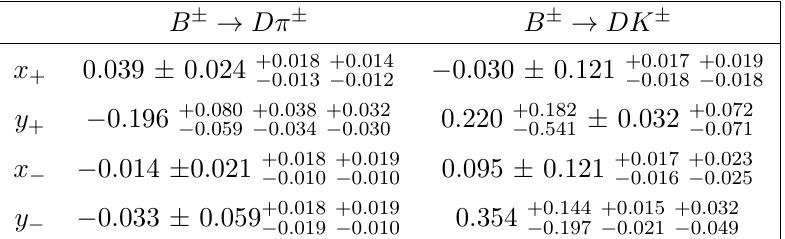
Table 6 . x (cid:6) and y (cid:6) parameters from a combined (cid:12)t to B (cid:6) ! D(cid:25) (cid:6) and B (cid:6) ! DK (cid:6) data samples. The (cid:12)rst uncertainty is statistical, the second is systematic, and the third is due to the uncertainty on the c i , s i measurements.